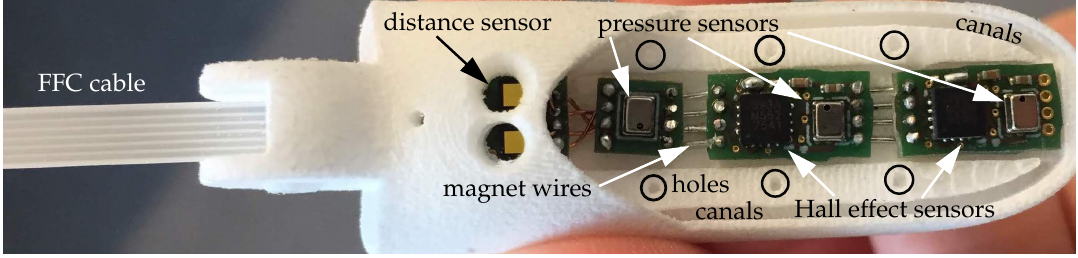
Figure 6. The individual tactile sensor printed circuit boards (PCBs), containing normal and shear force sensors and an accelerometer, as well as the distance sensor and design details are